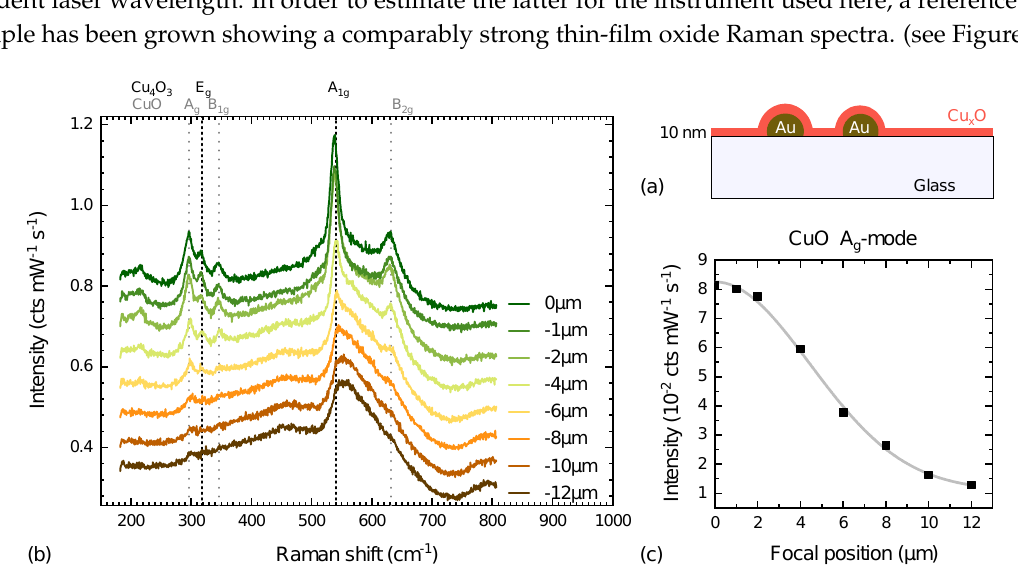
Figure 3. ( a ) Sample geometry of the Cu x O/glass sample with Au nanoparticle (NP) dimers; ( b ) Raman spectra of the sample moving the focal point into the sample. The 0 height is the position where the thin film signal was found to be strongest. By shifting the sample by 12µm upwards, no CuO Raman modes remain and only the glass Raman spectra is observed; ( c ) Intensity of the CuO A g Raman mode at 300cm − 1 as a function of focal depth, as well as a fit of the line shape using a Gaussian